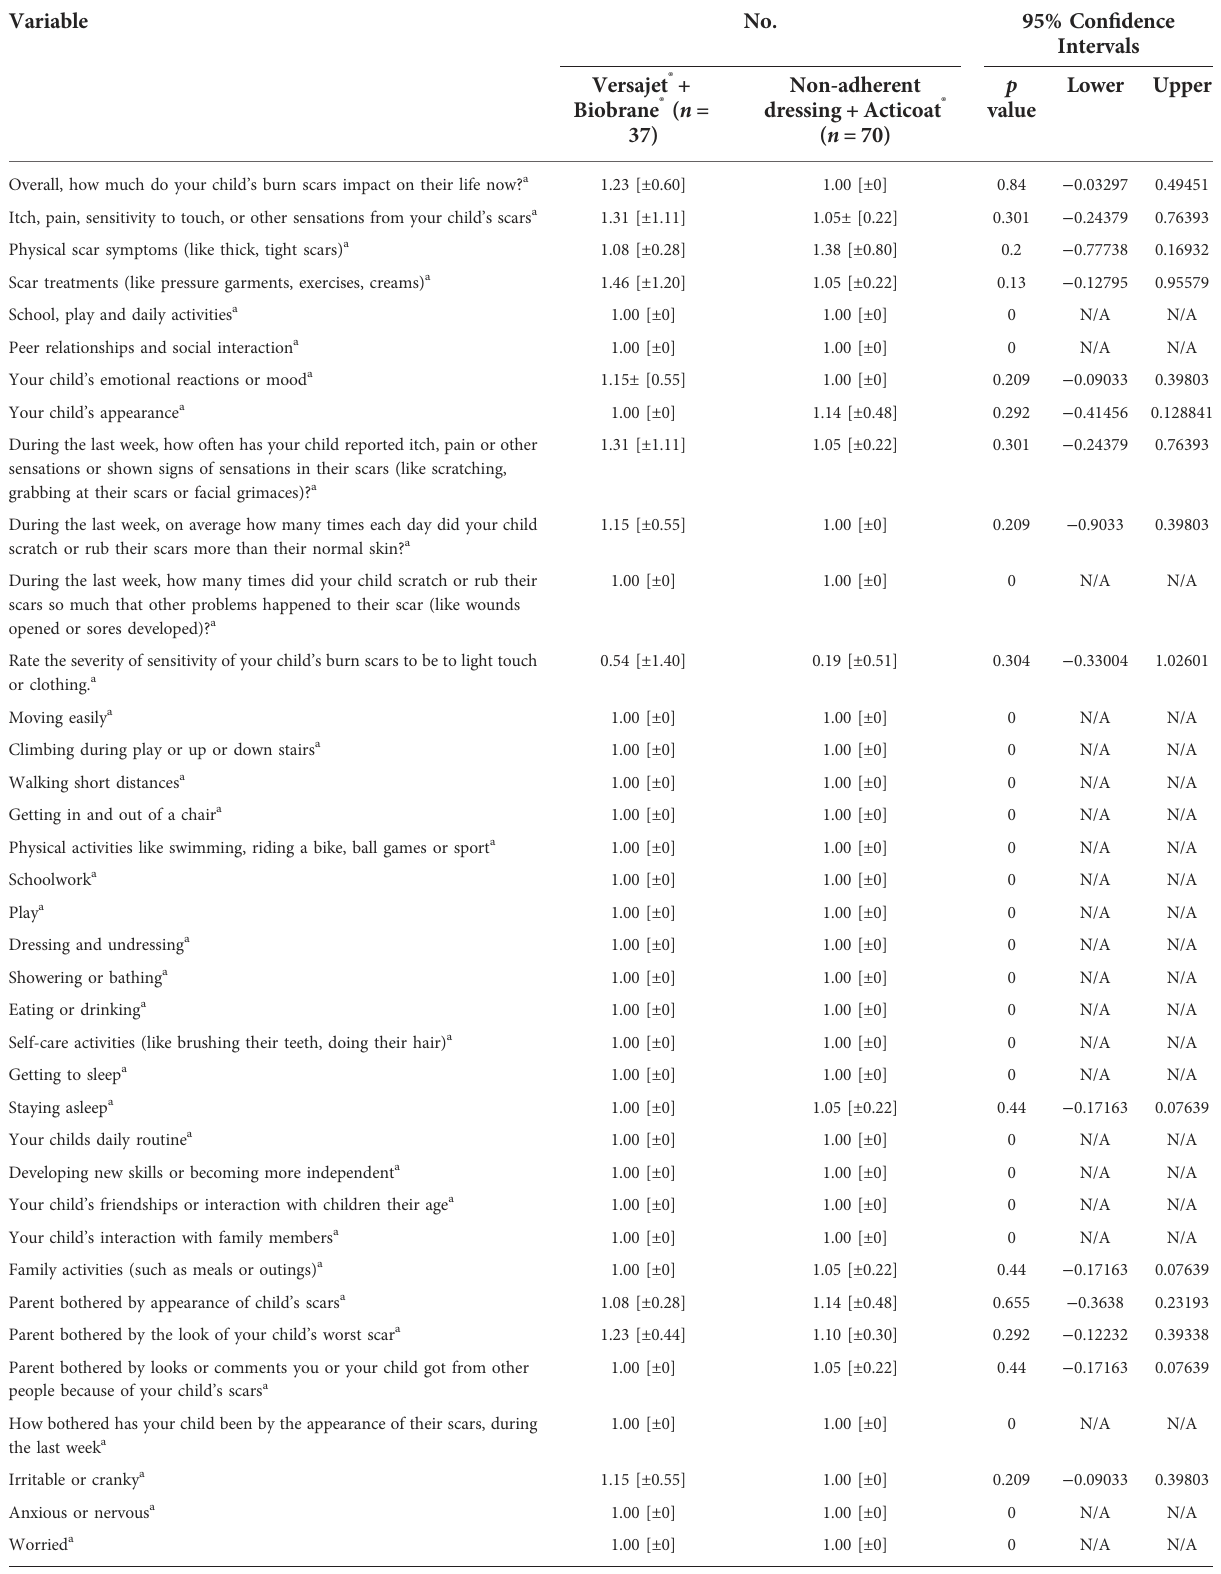
TABLE 3 Long term BBSIP outcomes for